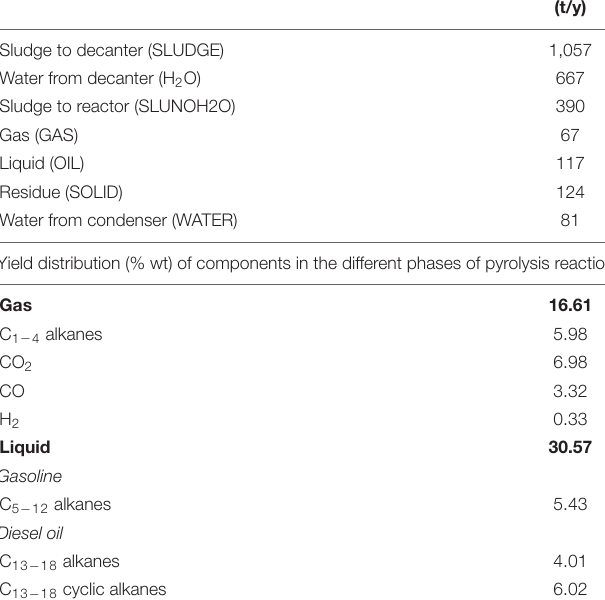
TABLE 2 | Simulation results for sludge pyrolysis process at T = 450 ◦ C. Stream (see Figure 2) Mass flow